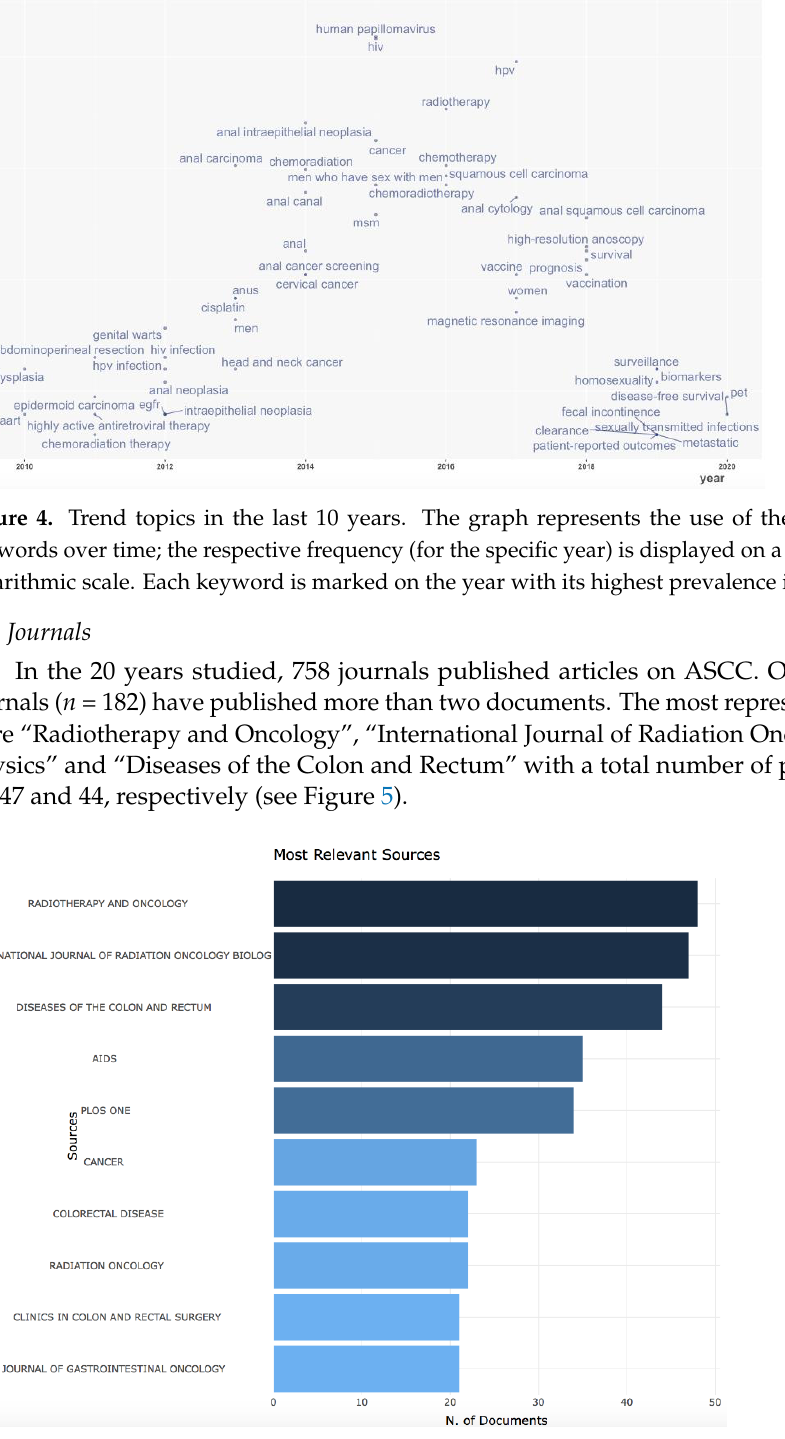
Figure 3. Factorial analysis of analyzed keywords. The distance between keywords indicates shared substance. The colors distinguish different clusters.